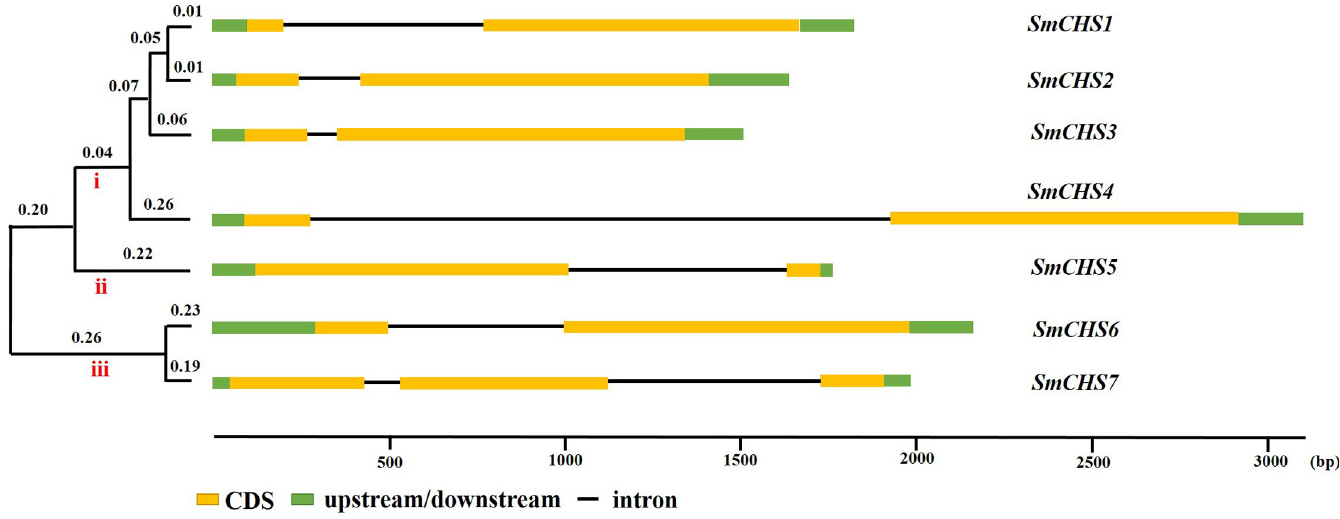
Fig 1. Phylogenetic relationship and gene structure analysis of SmCHS